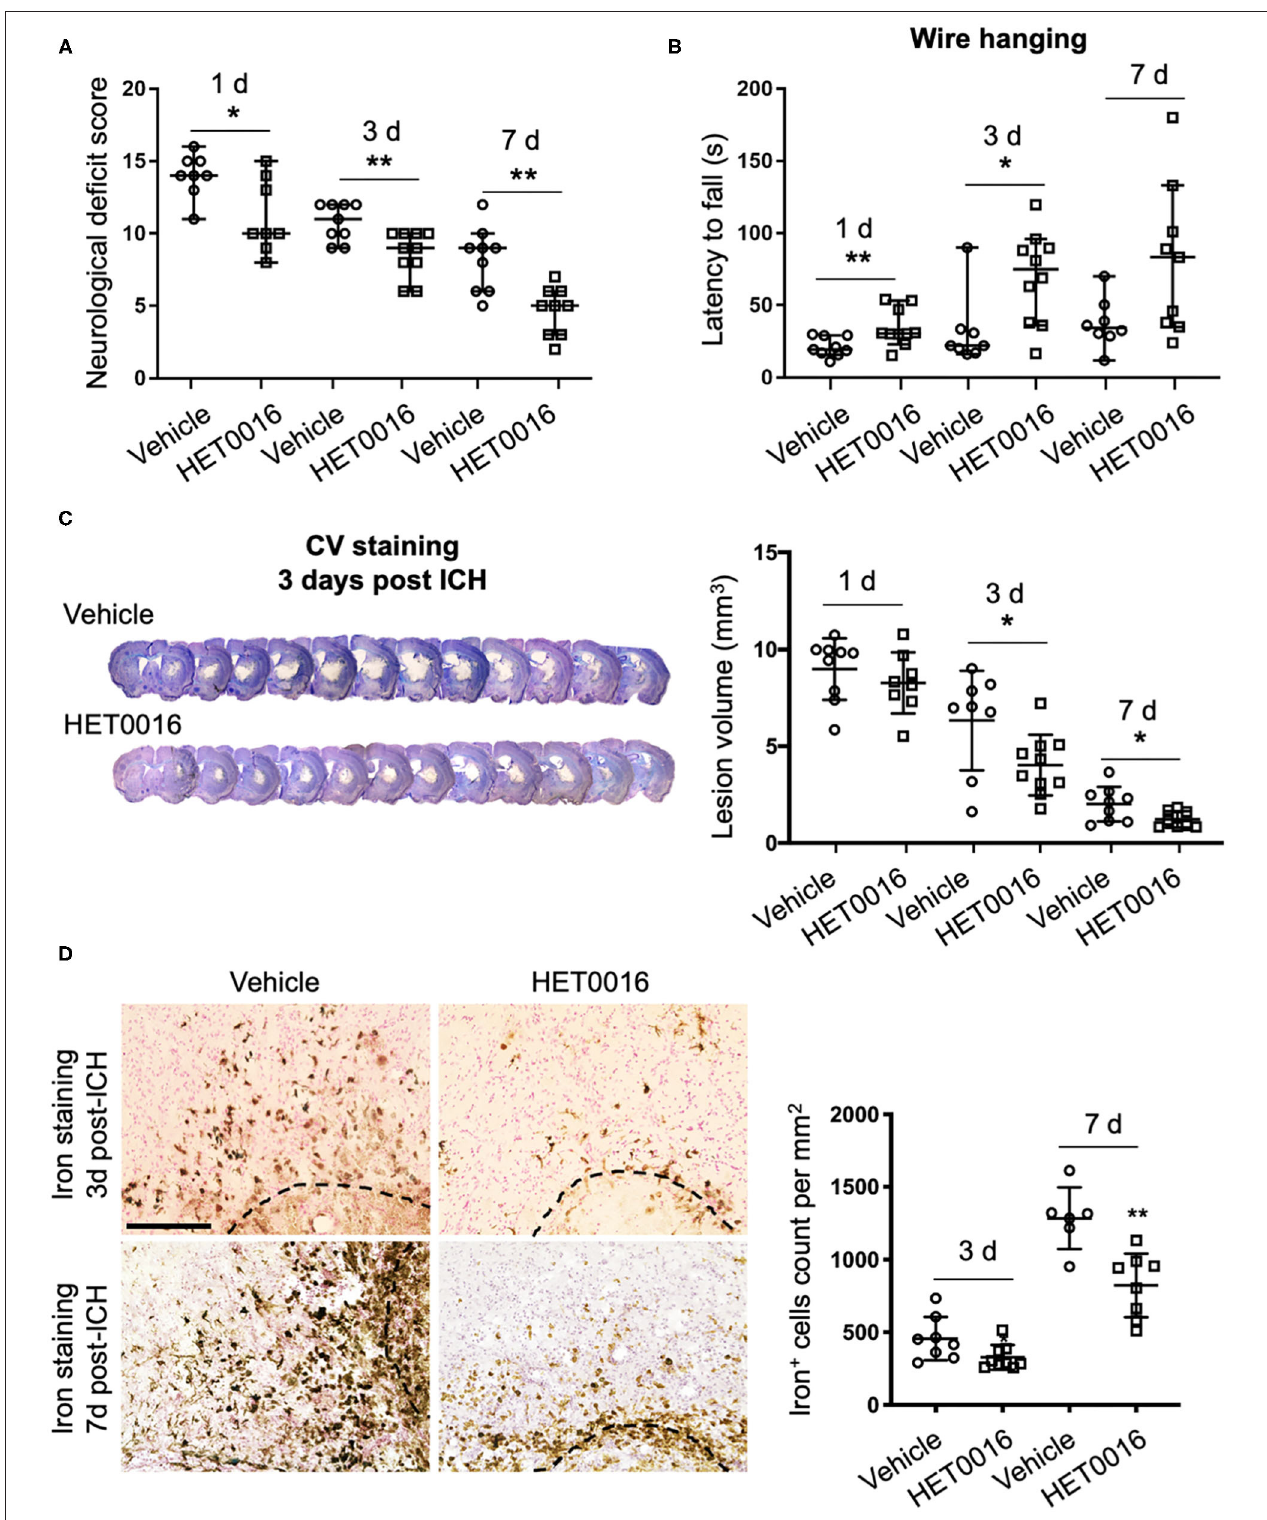
FIGURE 4 | HET0016 ameliorates ICH injury severity in mice. (A) HET0016 treatment improved neurological deficit scores of mice at 1, 3, and 7 days after ICH. n = 8–10/group. (B) HET0016-treated ICH mice exhibited longer latency to fall in the wire-hanging test than did vehicle-treated mice at 1, 3, and 7 days after